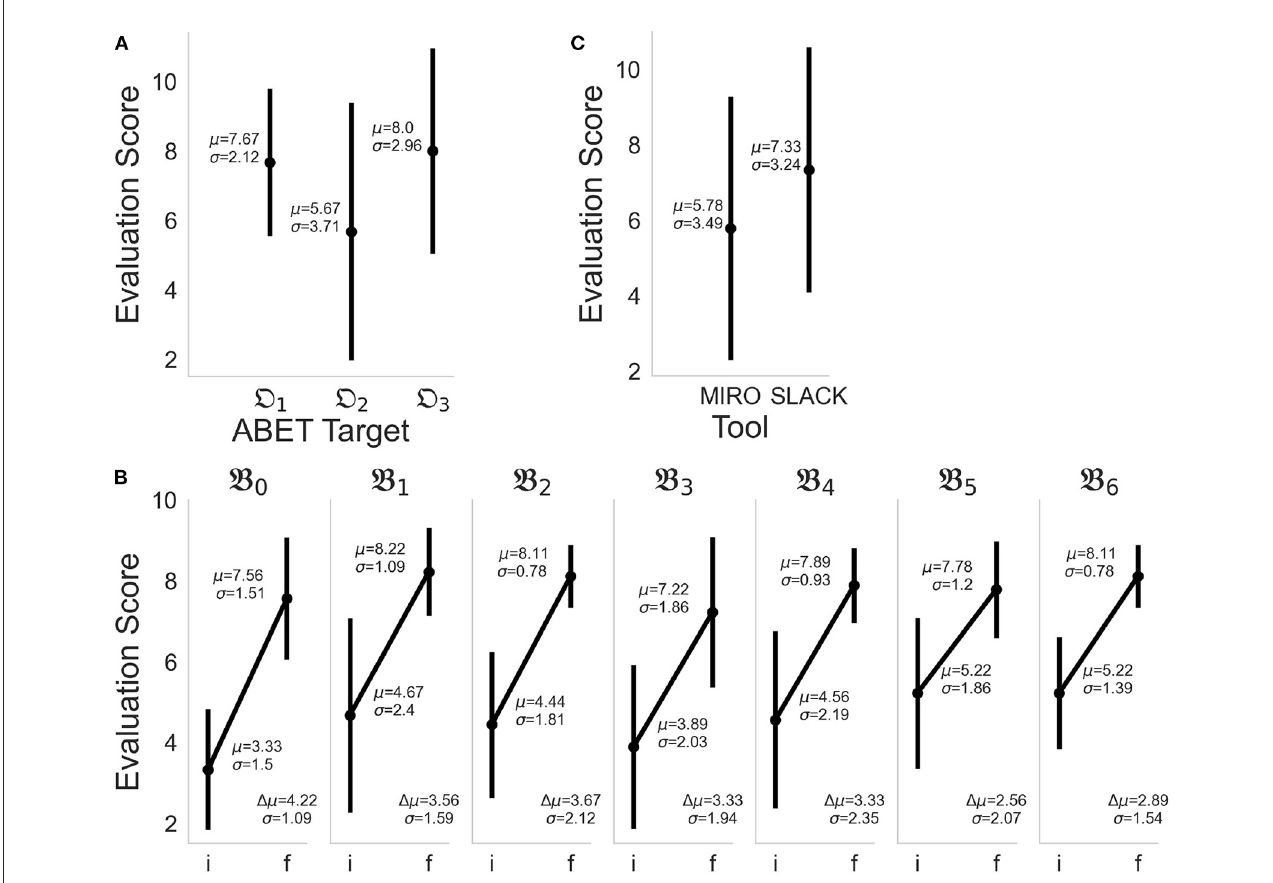
FIGURE22 Course outcome evaluation calculations based on student survey. Students were asked to evaluate a number of questions based on a 1–10 scale with 1 being to lowest and 10 being the highest. (A) Calculated student survey responses addressing ABET Outcomes O . O 1 corresponds to an ability to recognize ethical and professional responsibilities in engineering situations and make informed judgments, which must consider the impact of engineering solutions in global, economic, environmental, and societal contexts. O 2 corresponds to an ability to function effectively on a team whose members together provide leadership, create a collaborative and inclusive environment, establish goals, plan tasks, and meet objectives. O 3 corresponds to an ability to acquire and apply new knowledge as needed, using appropriate learning strategies. (B) Calculated student survey responses addressing targeted learning outcomes B based on Bloom’s taxonomy. B 1 is to Analyze how the Manhattan project was influenced by these discoveries. B 2 is to Sequence the complex historical basis for nuclear armament. B 3 is to Summarize the landmark players that shaped the nuclear engineering communities. B 4 is to Summarize the persistent problems in nuclear policy and engineering from a historical perspective. B 5 is to Analyze how current persistent problems in nuclear policy and engineering can be related to problems solved through a historical perspective. B 6 is to Synthesize solutions to current persistent problems in nuclear policy and engineering from solutions to past problems. B 7 is to Analyze impact of nuclear physics on international relations and world affairs. (C) Remote Learning Tool